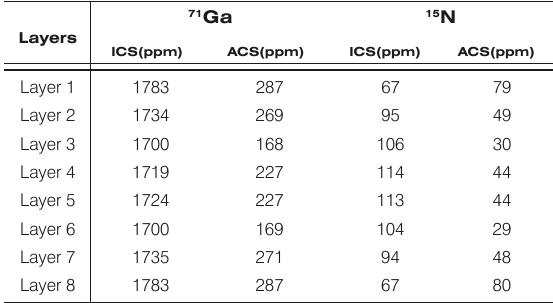
Table 4. The NMR parameters in the Li-capped (4, 4) GaNNT.